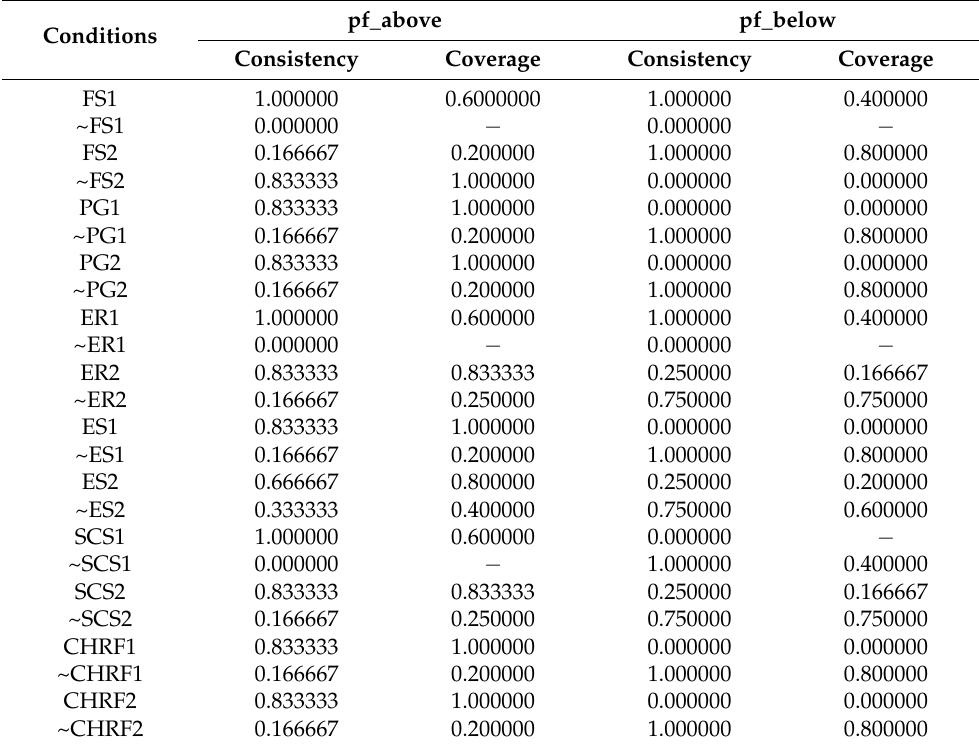
Table 2. Analysis of necessary conditions. For a detailed description of the meaning of the variables, please refer to Table